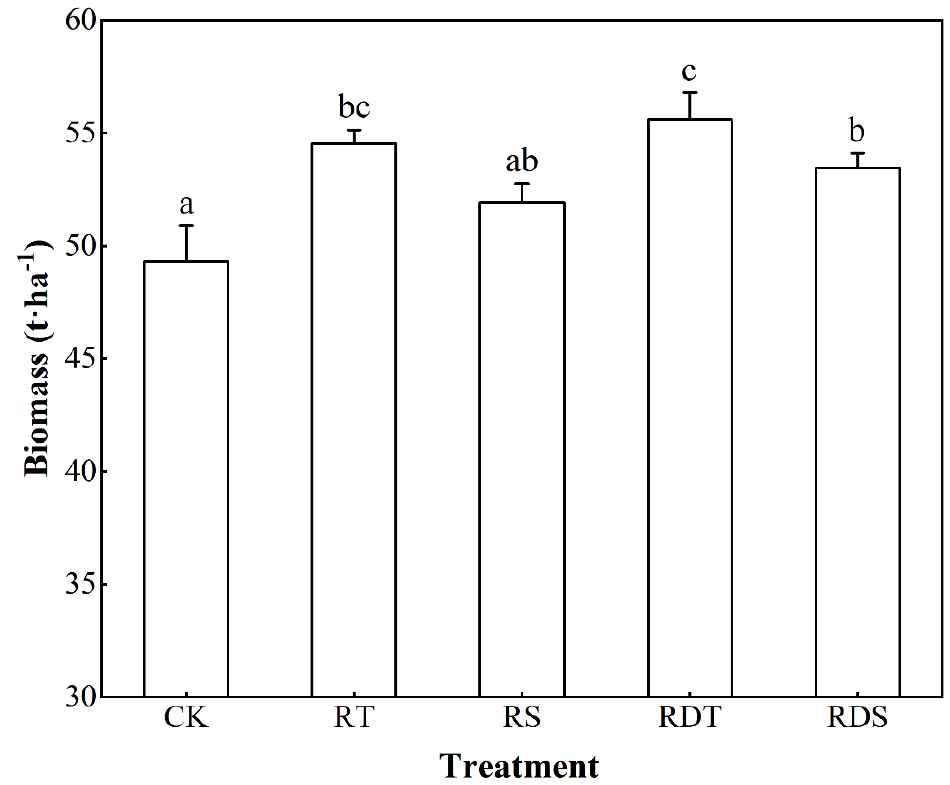
Figure 3. Melaleuca alternifolia biomass of different treatment methods of residues. Notes: Different